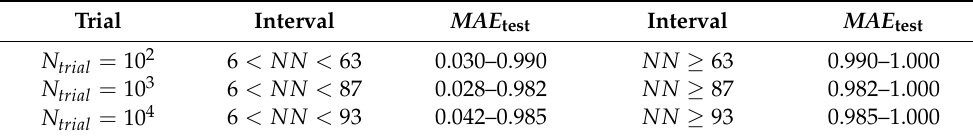
Table 16. The ranges of MAE test for different N trial .